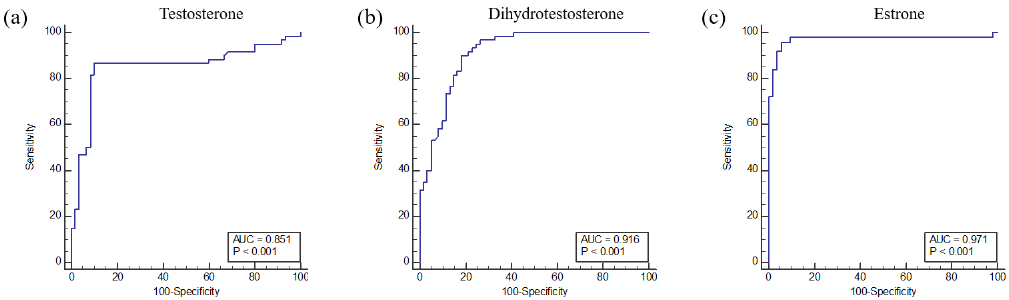
Figure 4. Univariate receiver operating characteristic (ROC) curve analyses for predicting biomarker performance in urine samples from pattern baldness patients who have been treated with finasteride for one year. Typical ROC curve plots of potential biomarkers with high-performance prediction; several metabolites of area under the curve (AUC) values > 0.8 were observed. ( a ) Testosterone, ( b ) dihydrotestosterone, and ( c ) estrone.